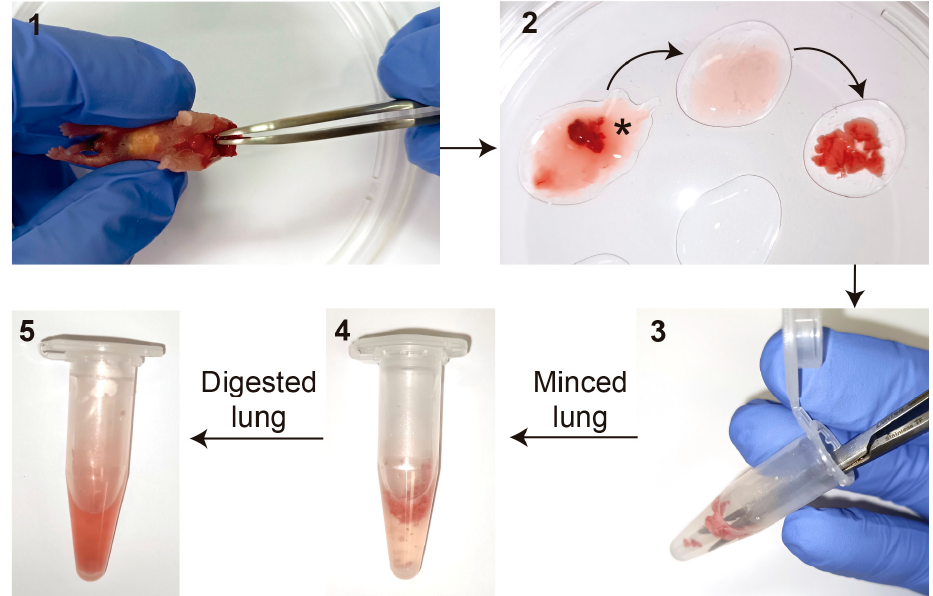
Figure 2. Protocol workflow. ( 1 ) Lung lobes attached to the heart are dissected from newborn mice without opening the peritoneal cavity. ( 2 ) Lung lobes in HBSS after elimination of heart, trachea, and other non-lung tissue. Asterisks indicate the discarded no-lung tissue. Arrows indicate the recommended washing steps in drops of HBSS to eliminate blood excess. ( 3 ) Lung lobes are minced with scissors in a 1.5 mL Eppendorf containing 0.5 mL of the Col/Disp digestion buffer. ( 4 ) Small pieces of the lungs after mincing. ( 5 ) Final appearance of fully digested lungs after Col/Disp and Trypsin incubations.